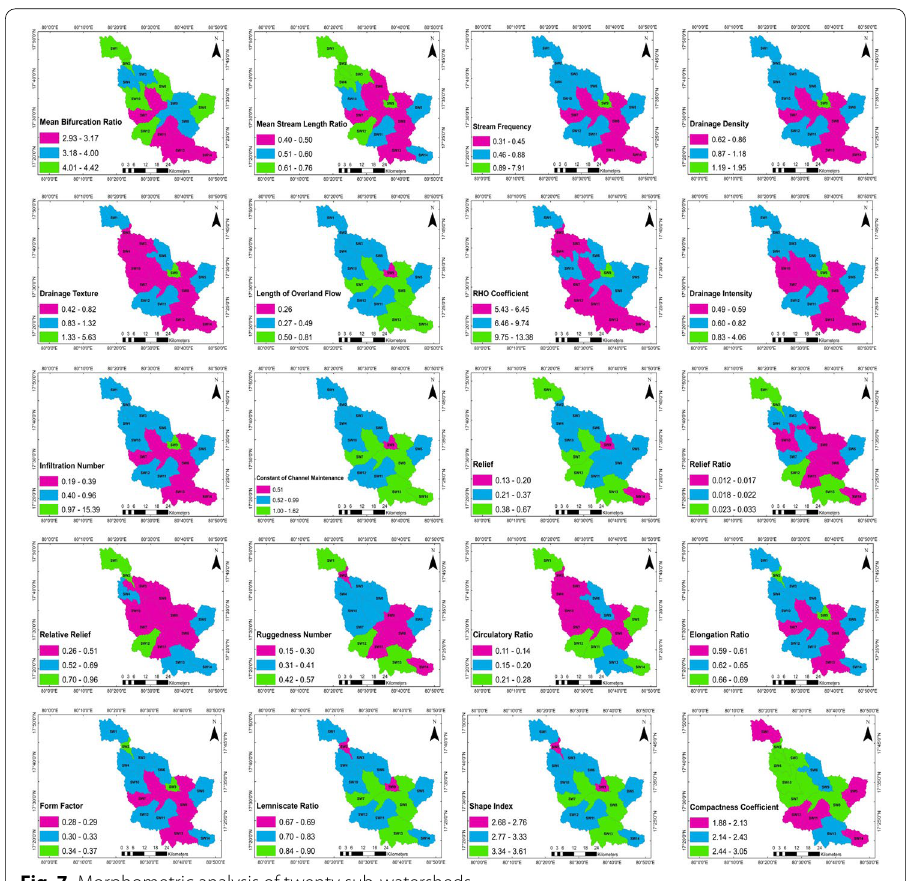
Fig. 7 Morphometric analysis of twenty